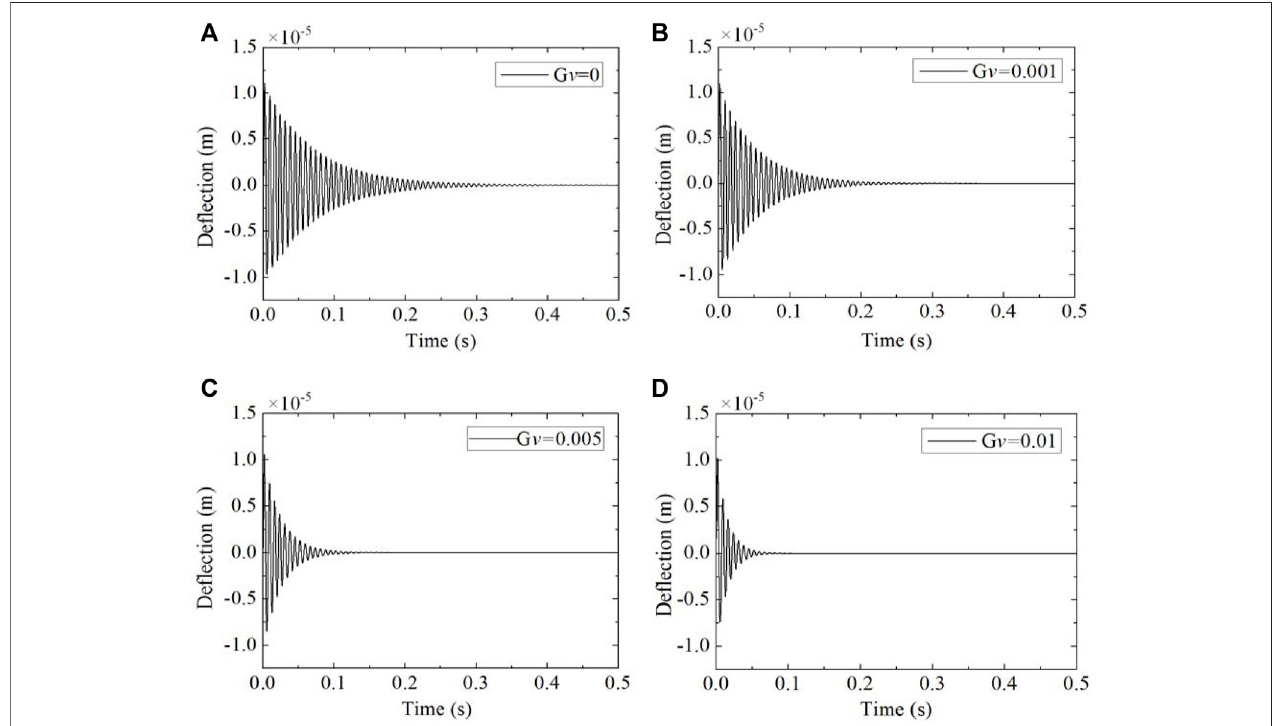
FIGURE 6 | Active vibration control of the piezoelectric-integrated FG plate under SSSS boundary conditions with different velocity feedback gains: (A) G v = 0; (B) G v = 0.001; (C) G v = 0.005; (D) G v =